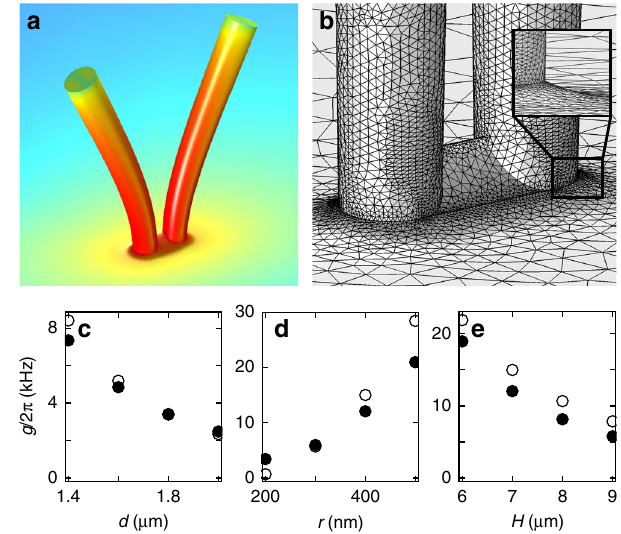
Fig. 5 Finite element simulation of nanopillar pairs. a Simulation of the stress distribution between two (identical) nanopillar resonators vibrating in the antisymmetric hybrid mode. Red (blue) corresponds to high (low) stress, respectively. b Finite element simulation model, highlighting the realistic clamping area of the pillar pair as well as the narrowing mesh implemented near the pillar feet. The inset shows a zoom of the transition from a nanopillar to the substrate. c – e Finite element simulation of coupling strength of vertical ( fi lled circles) and horizontal (empty circles) modes as a function of c center-to-center distance d ( r ¼ 400 nm , H ¼ 7 μ m ), d nanopillar bottom radius r ( d ¼ 2 r þ 400 μ m , H ¼ 7 μ m ) and e nanopillar height H ( r ¼ 400 nm , d ¼ 1 : 2 μ m ). The taper angle for all simulations